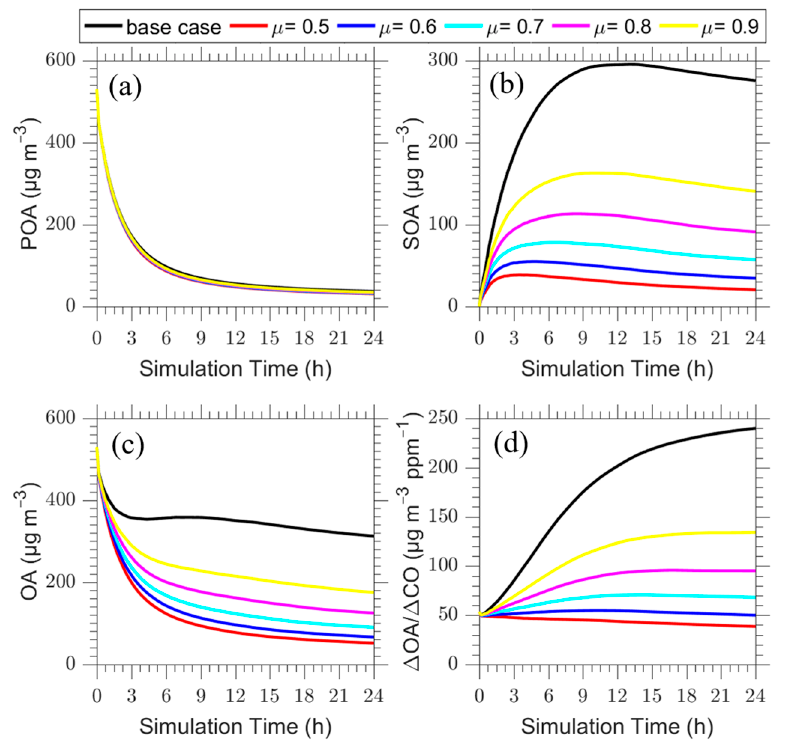
Figure 8. Time series of ( a ) POA (in μ g m − 3 ), ( b ) SOA (in μ g m − 3 ), ( c ) total OA (in μ g m − 3 ) and ( d ) Δ OA/ Δ CO (in μ g m − 3 ppm − 1 ) for the seventh layer of the base case ( black line ) in comparison to the cases with μ = 0.5 ( red line ), μ = 0.6 ( blue line ), μ = 0.7 ( cyan line ), μ = 0.8 ( magenta line ) and μ = 0.9 ( yellow line ).